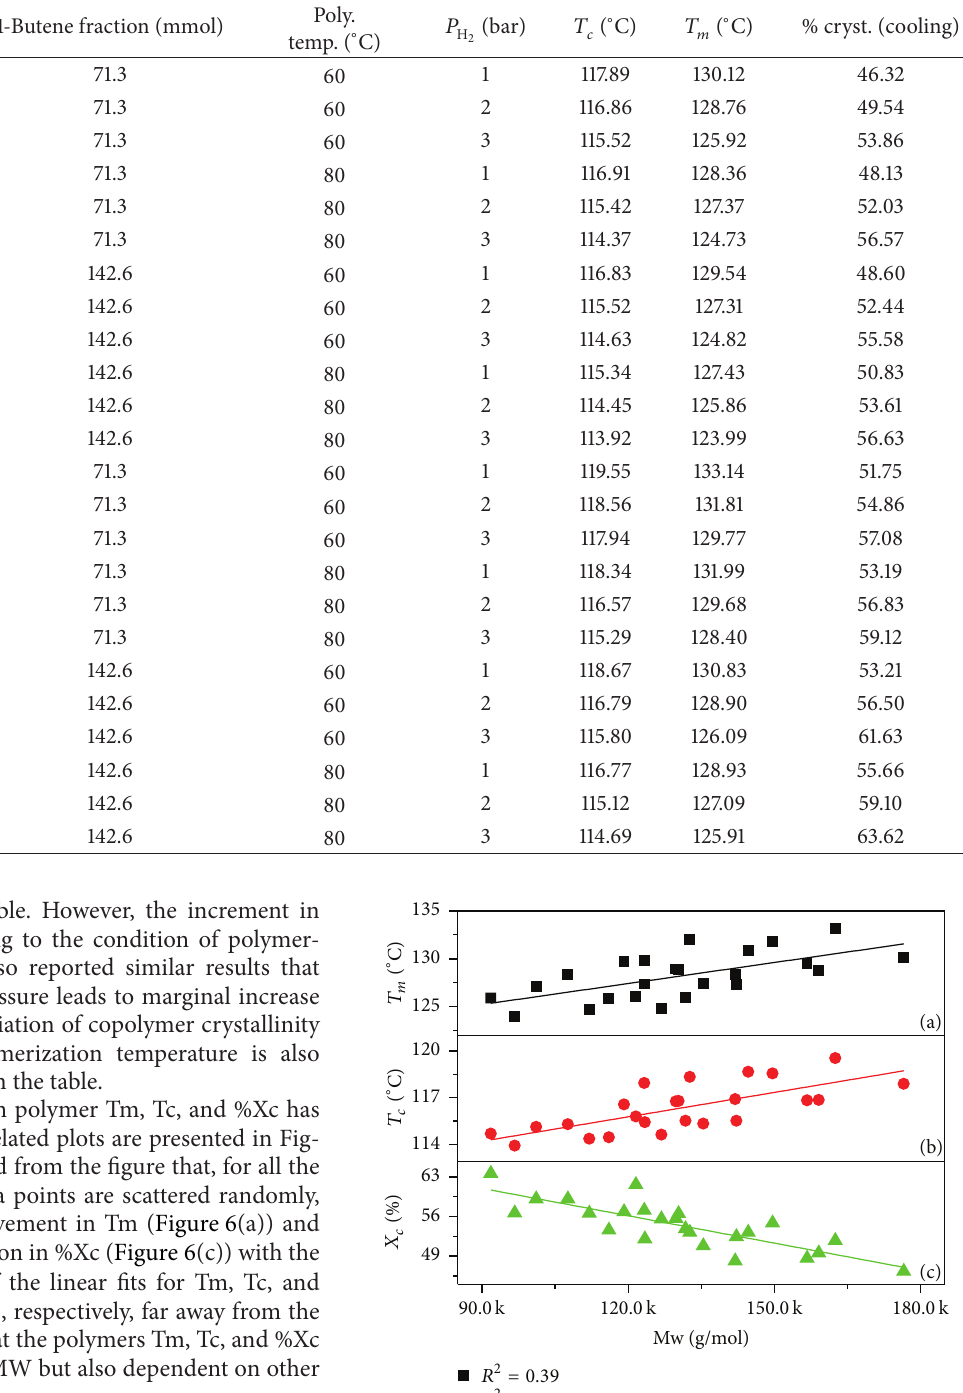
Table 3: DSC analysis for copolymer samples (polymerization time 30min).